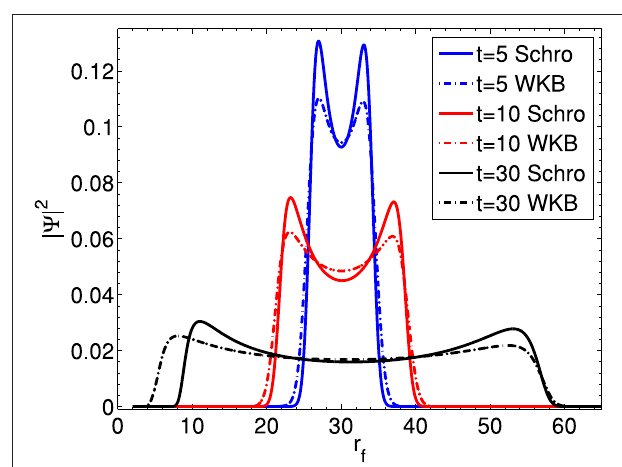
FIGURE 6 | mM / ¯ h = 1 Schrödinger (solid line) and WKB comparison (dotted